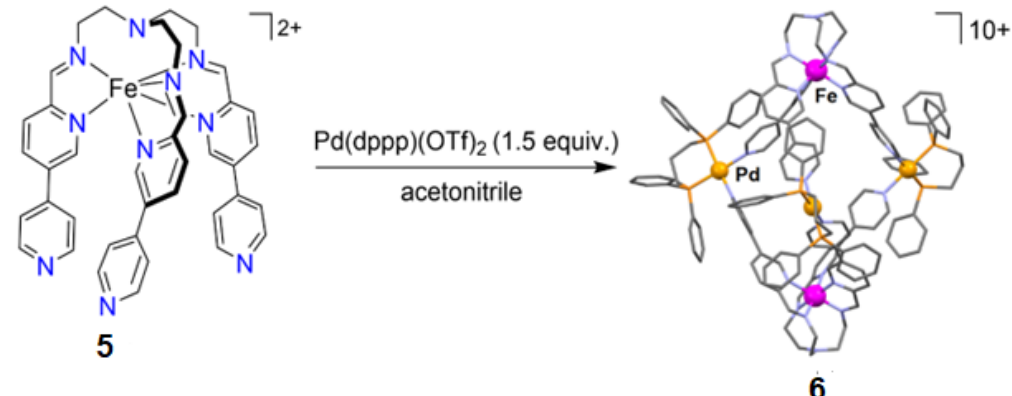
Figure 5. Assembly of the [(Fe II L) 2 {Pd II (dppp)} 3 ] 10+ cation 6 from metalloligand 5 and